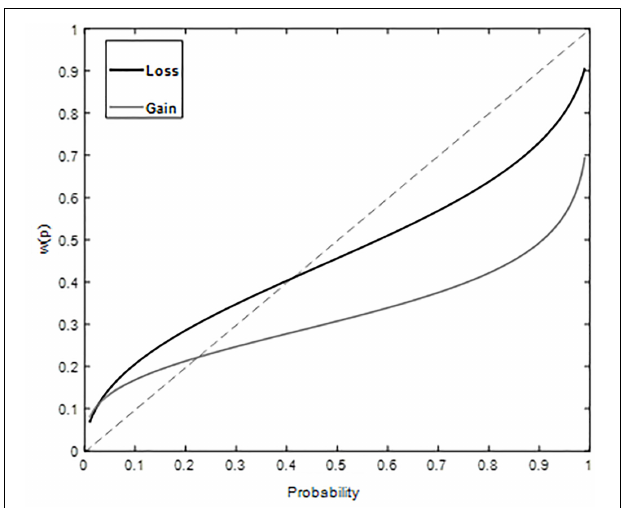
FIGURE 2 | Weighted Probability for gains and losses plotted against probability in Study 1. Overweighting of small probabilities and underweighting of large probabilities is observed for both gain and loss